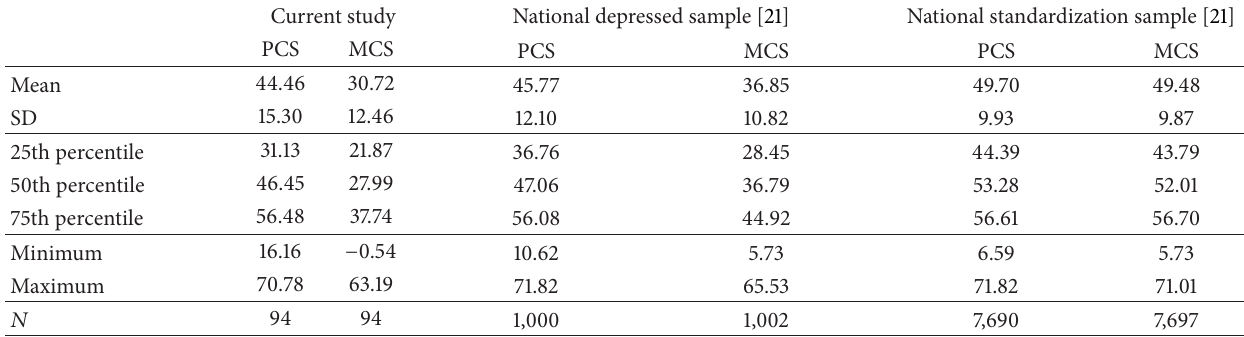
Table 1: SF-12v2 norm